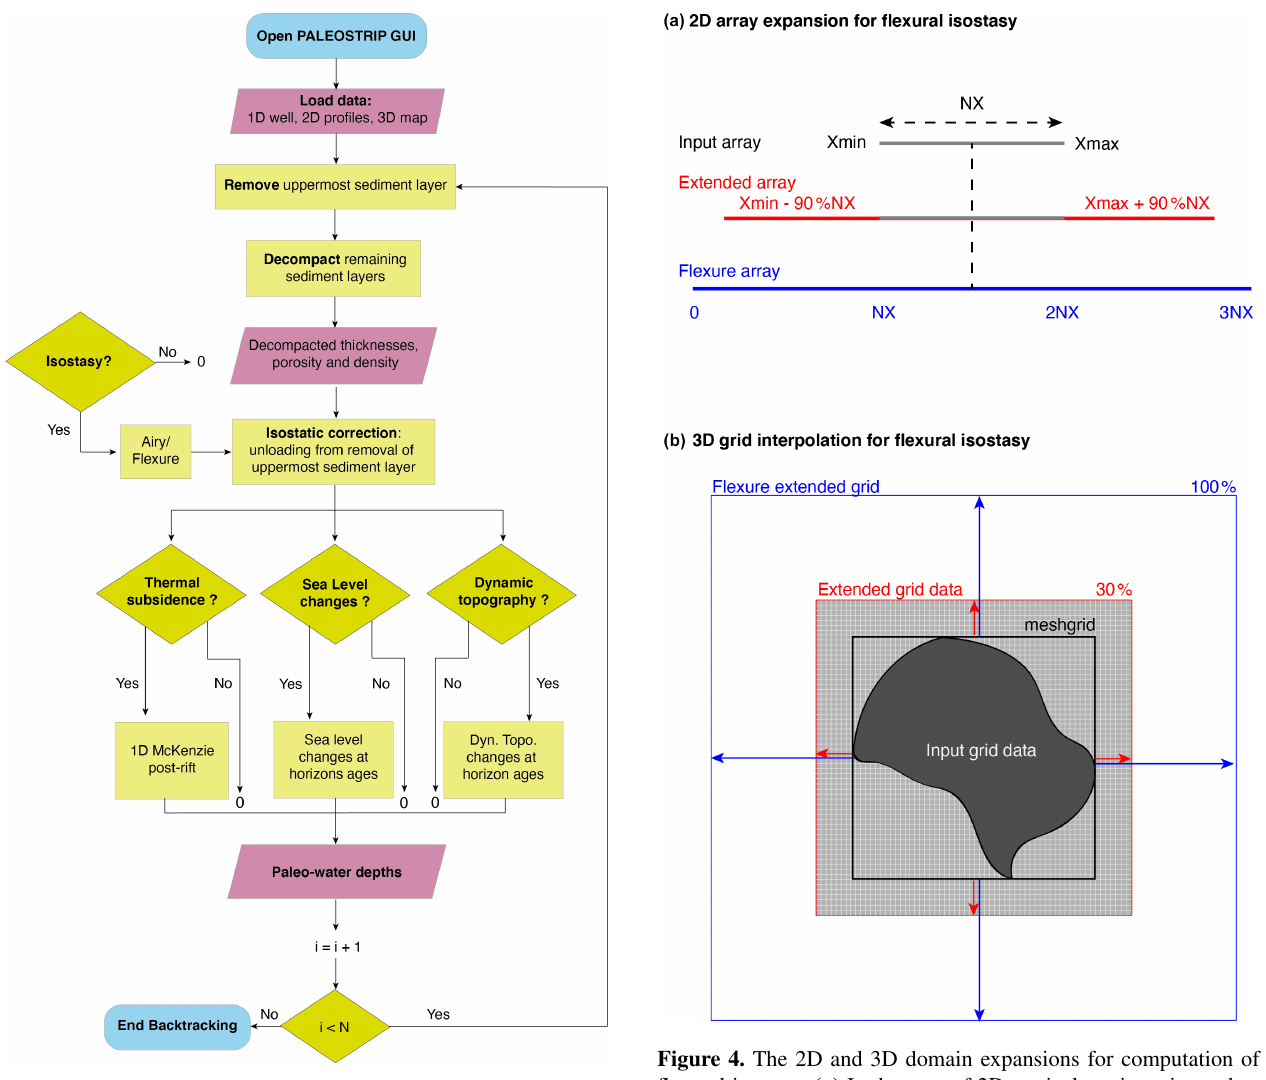
Figure 3. Workflow of the code implemented in PALEOSTRIP il- lustrating the various steps of computation according to selected options in the GUI. N sediment layers are decompacted during the backtracking procedure. Smooth blue rectangles correspond to the start and end of the backtracking run. Light red parallelograms indi- cate input and output data. Light green rectangles are intermediate steps in the backtracking computation. Green diamonds correspond to options selected by the user in the GUI. If isostasy, thermal sub- sidence, sea level changes, or dynamic topography are switched off, the corresponding correction equals zero.